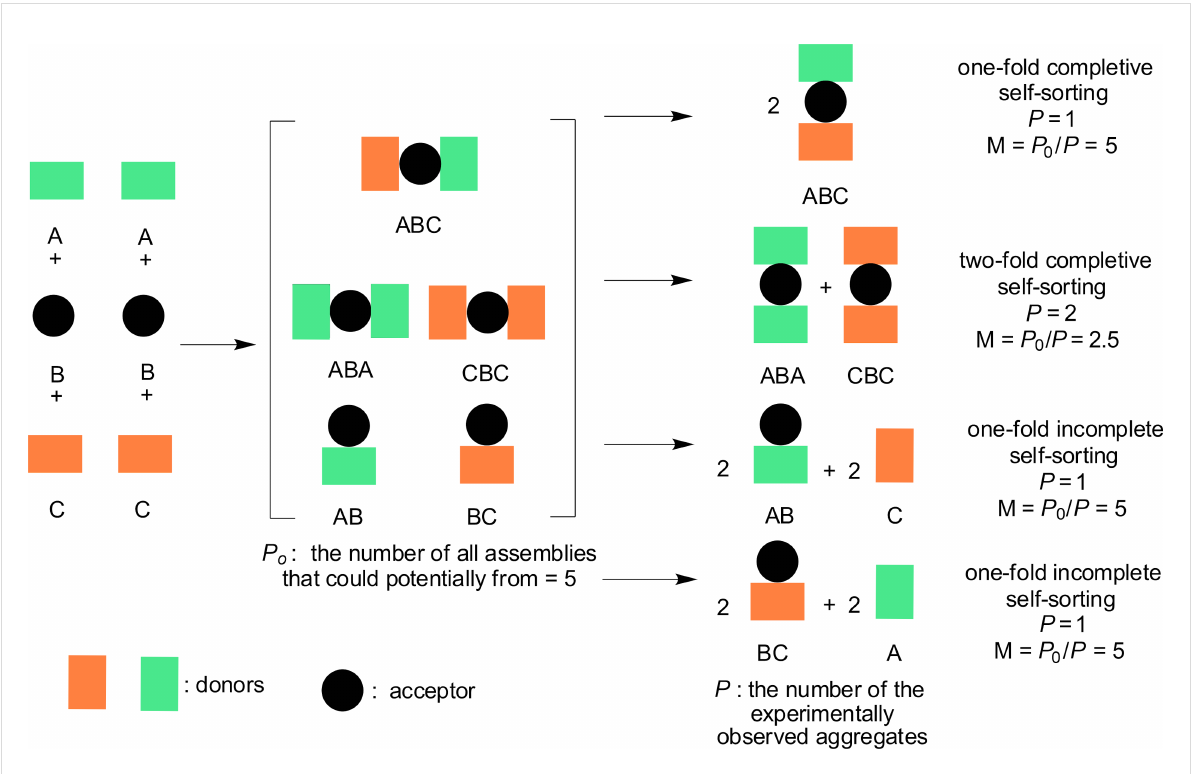
Figure 1: Some selected self-sorting outcomes and their qualitative and quantitative